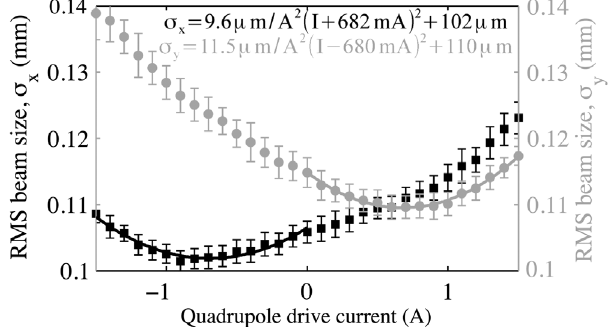
14. Beam width after focusing with the quadrupole electromagnet powered in quadrupole configuration. Horizontal RMS width is black and vertical RMS width is